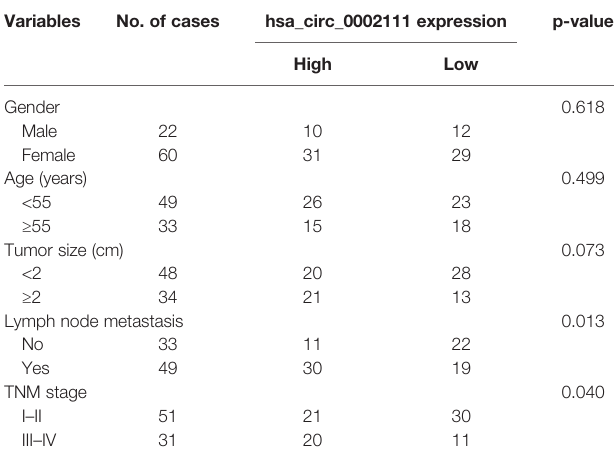
TABLE 1 | Correlation between hsa_circ_0002111 expression and clinicopathological features of papillary thyroid cancer (PTC).